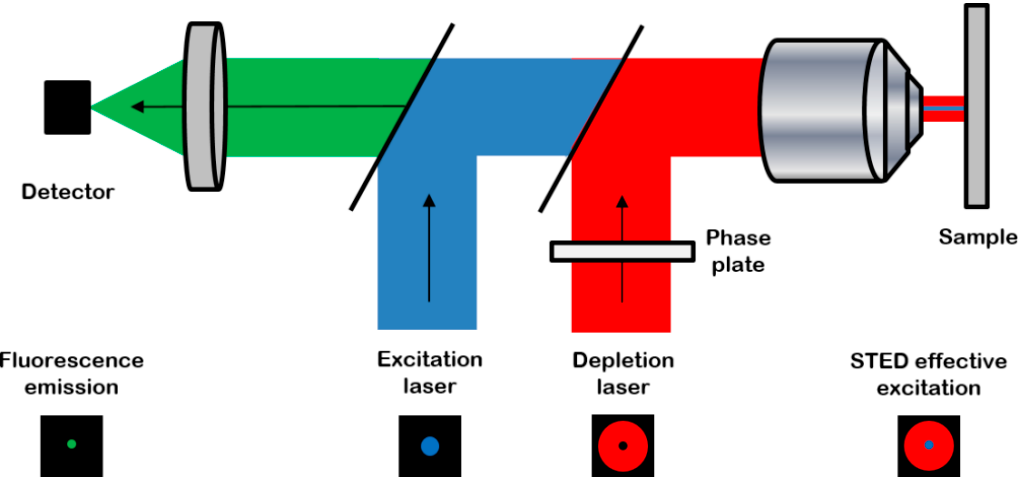
Figure 1. The principle of a stimulated emission depletion (STED) microscope (from reference [9]): the system combines the excitation laser (blue) with a depletion laser (red) passing through a phase plate to be modeled in “doughnut-shape” in the focal plane. The resulting excitation is an overlap of the two beams, leading to a high-resolution probe scanning the sample. Then the resulting effective detected fluorescence emission (green) is collected with high spatial and axial resolutions. Reproduced with permission from Journal of Internal Medicine published by Springer.